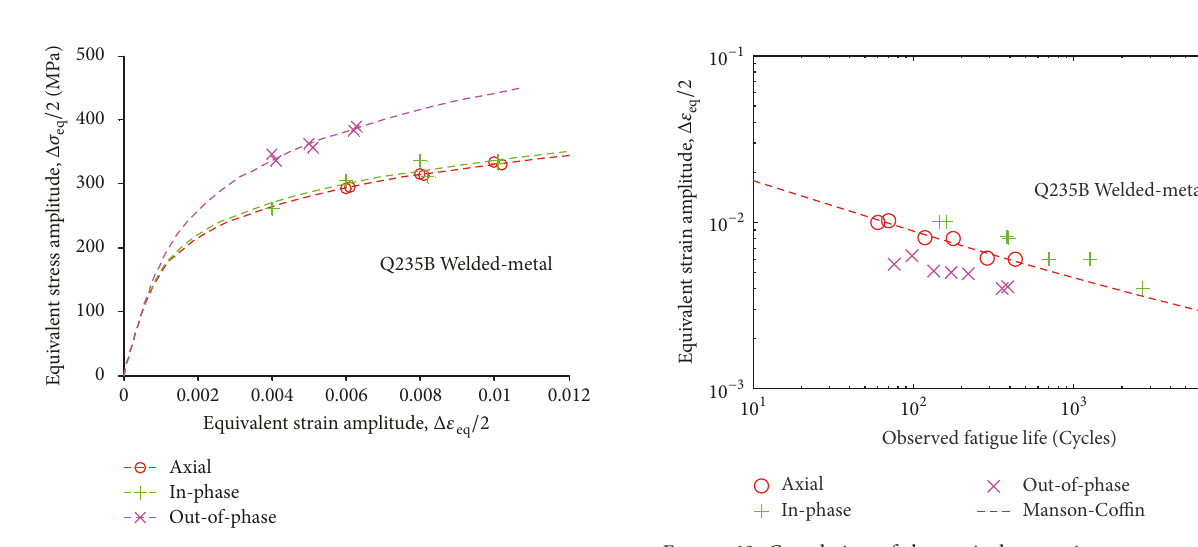
Figure 17: The cyclic stress-strain curves of Q235B weldment under different loading paths.